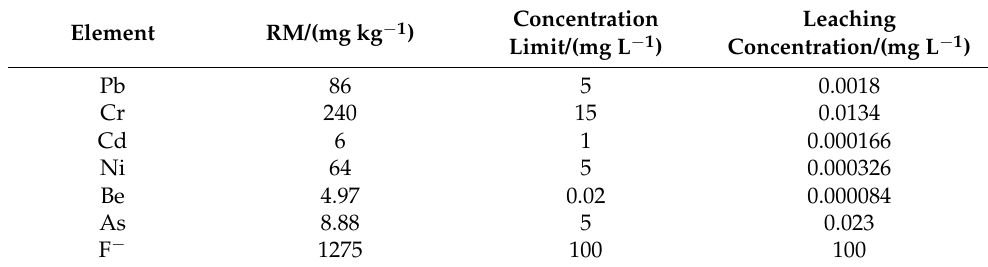
Figure 3. Particle size distribution of red mud and loessial silt.